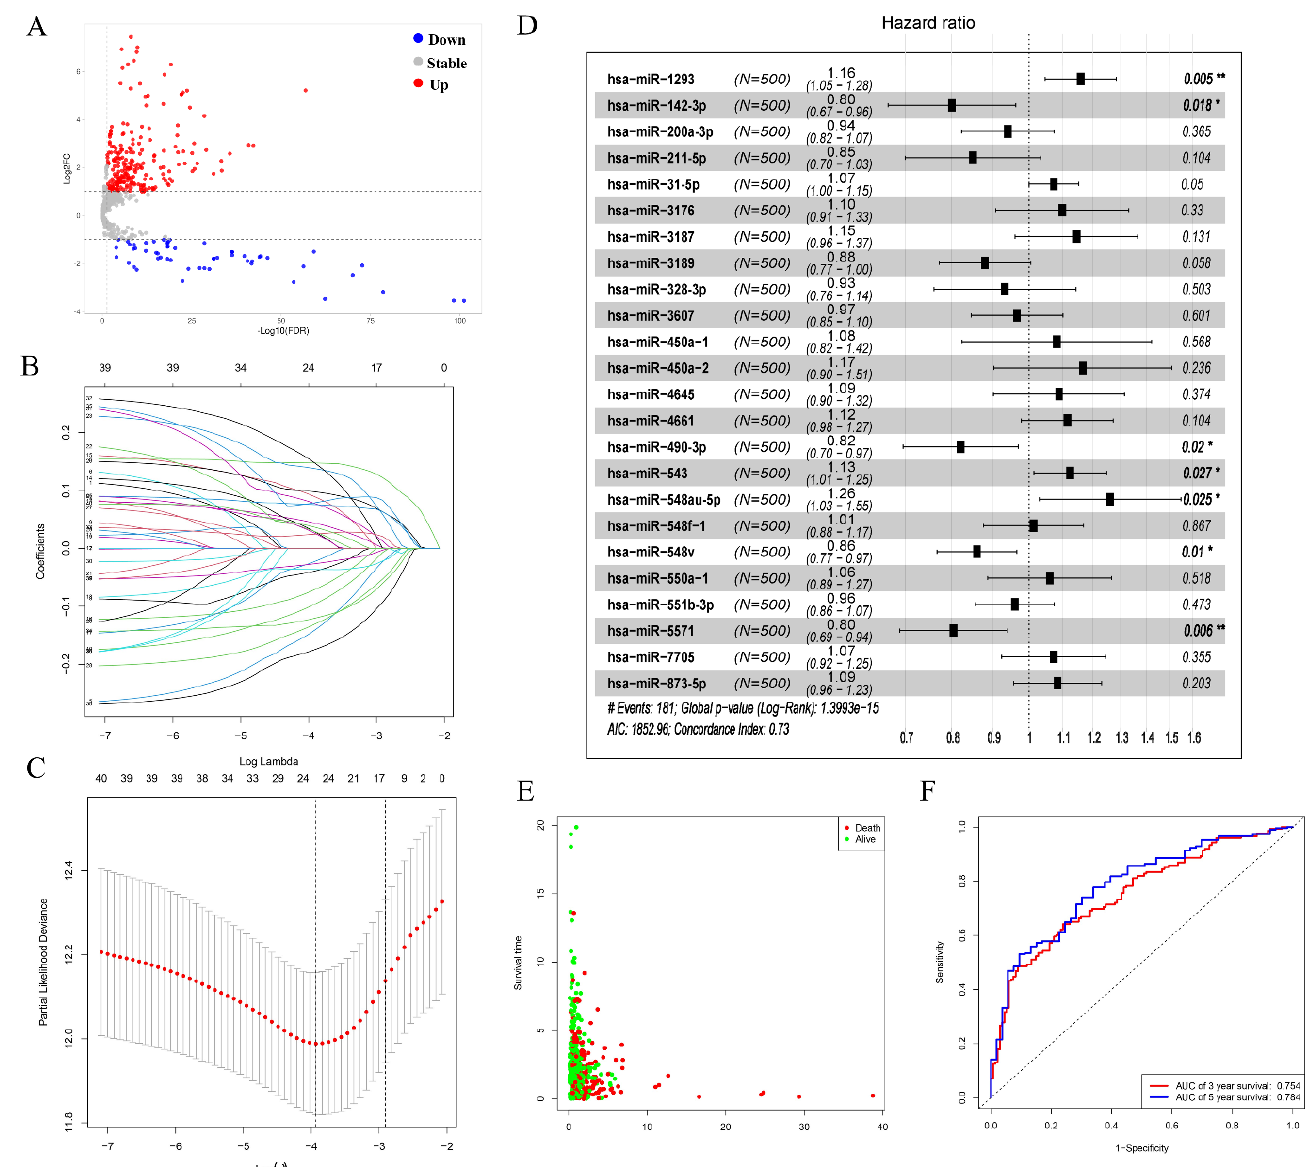
Figure 2. Prognostic-related differential miRNAs from TCGA. ( A ) Volcano plots for DEMs in LUAD derived from the TCGA database. the red points and blue points represent up and down expressed miRNAs, respectively. ( B , C ) Determination of the number of factors by the LASSO analysis, LASSO coefficient profiles of 41 prognostic miRNAs. ( D ) Forest plot displaying the hazard ratio and 95% confidence interval for the key prognostic miRNAs. ( E ) Survival status of LUAD patients. ( F ) Time- dependent receiver operator characteristic curves for OS prediction at 3- and 5-years. “*” means p < 0.05, “**” means p <